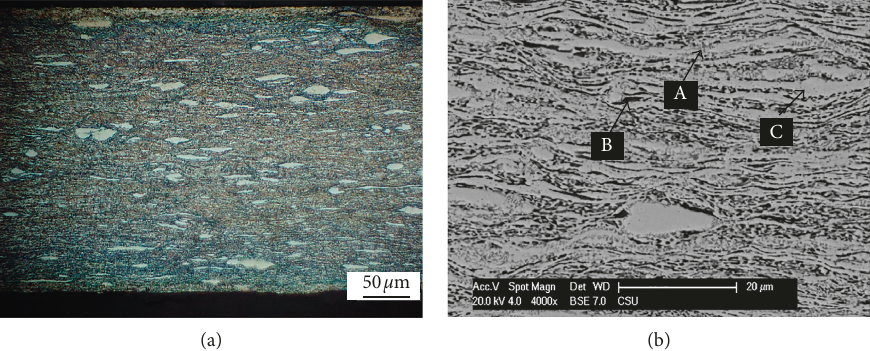
Figure 4: Microstructure of the as-rolled Zn-Al-Cu alloy: (a) optical micrograph; (b) backscattered electron image.